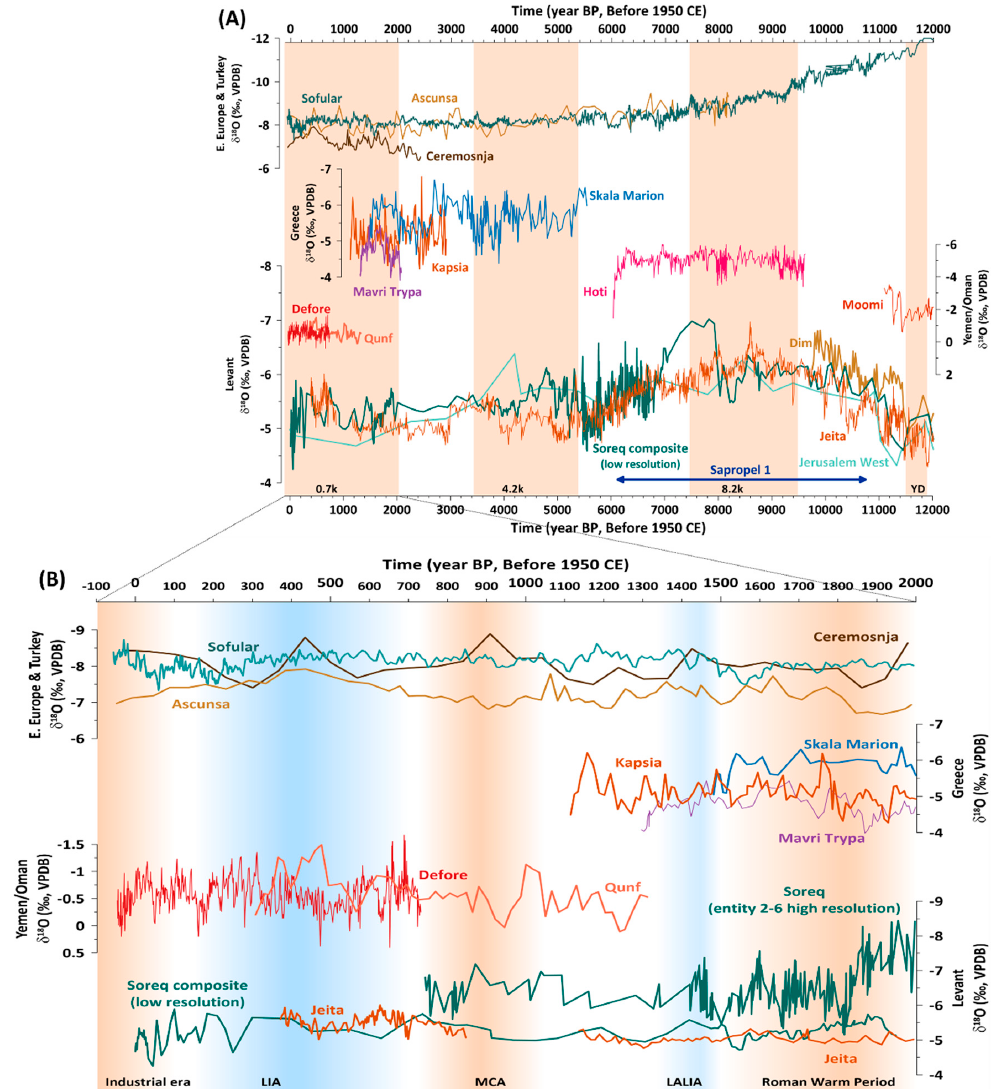
Figure 5. ( A ) Time-series of δ 18 Occ of speleothem records for the last 12 kyr. speleothem records are the same than in Figure 4, which are on the modern dominant storm trace to the ME region shown in Figure 2. ( B ) Temporal variability of entities in panel A for the last 2 kyr. The seasonally-resolved entity 2–6 (Soreq Cave) is added for discussion [14]. The climatic events highlighted on the plot are based on the interpretations from references [30,131].